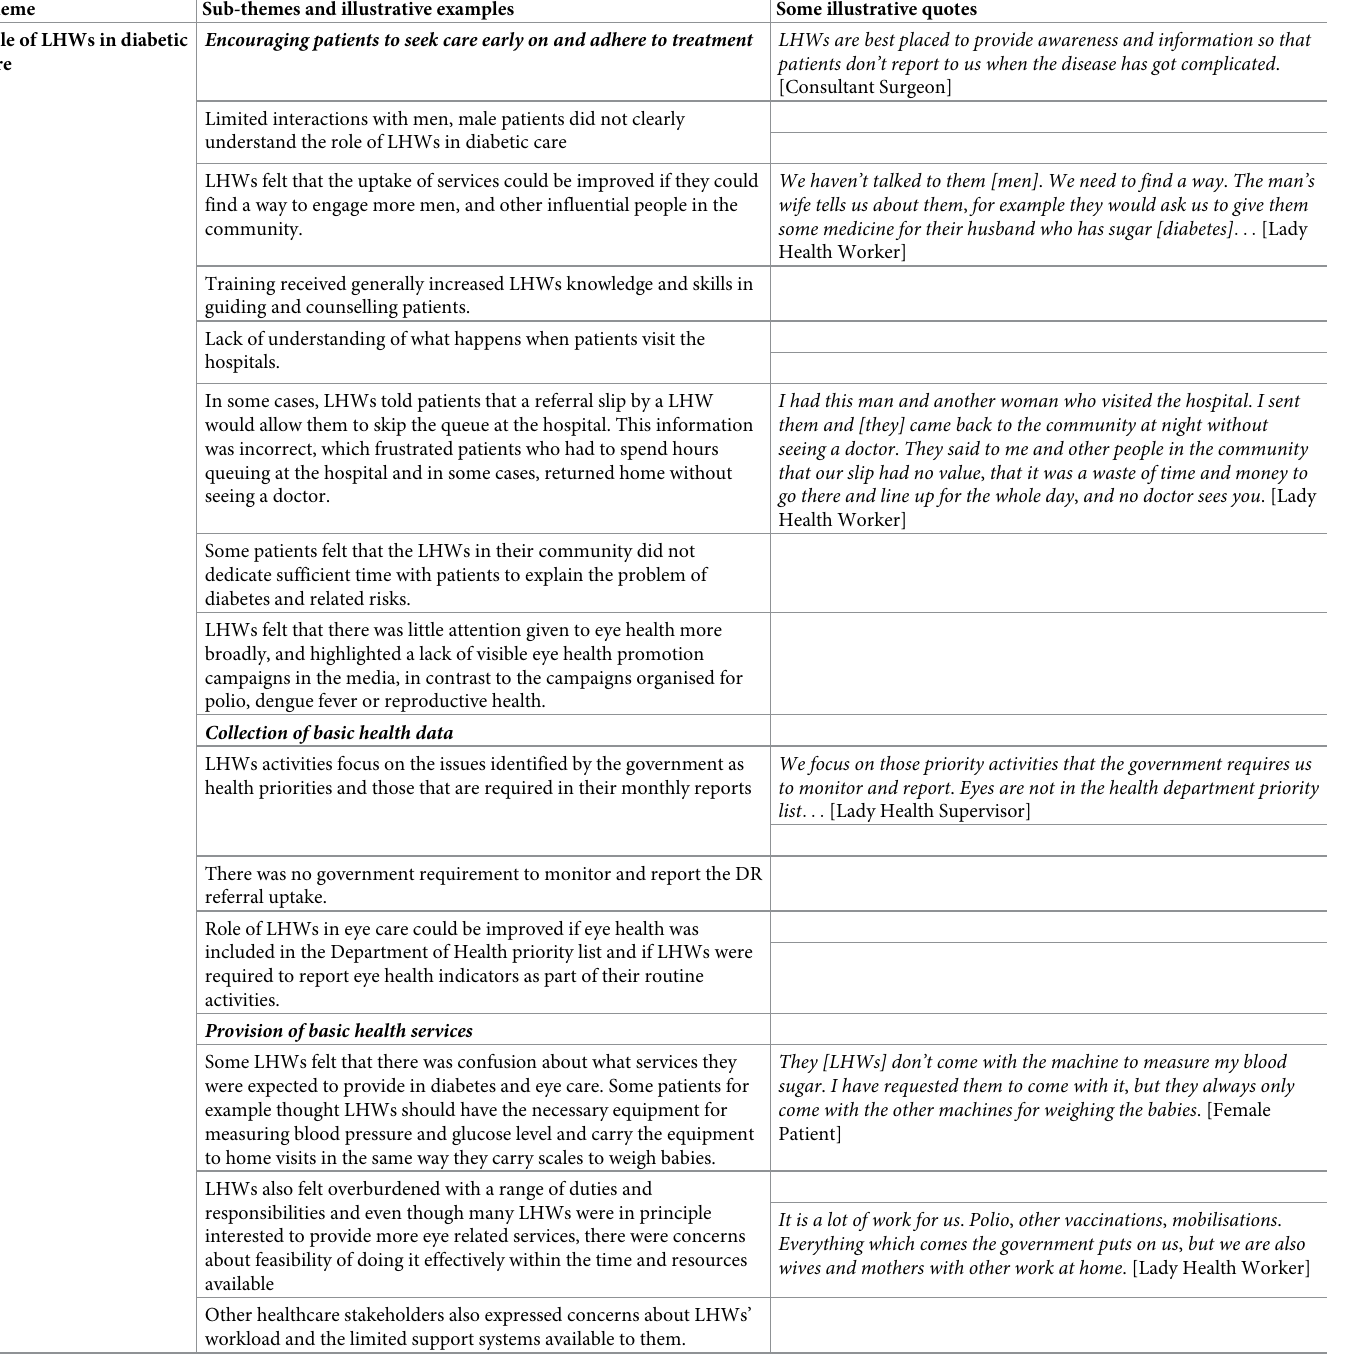
Table 1. Overview of themes and